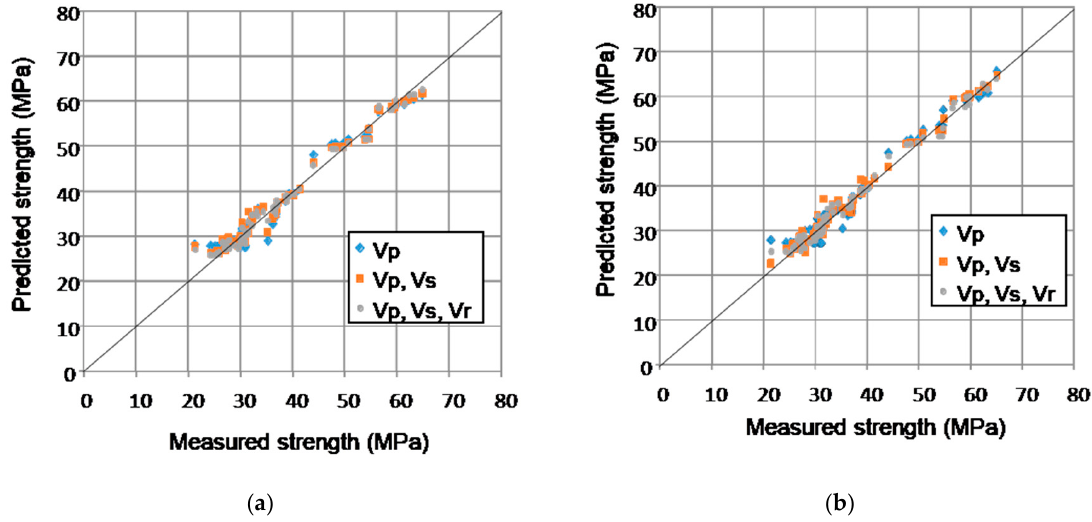
Figure 9. Correlation of predicted to measured concrete strength using the SVM and ANN models.